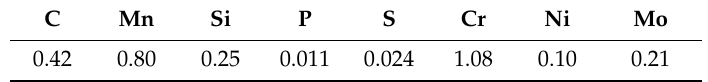
Table 1. Chemical composition of the 42CrMo4 medium carbon steel (in